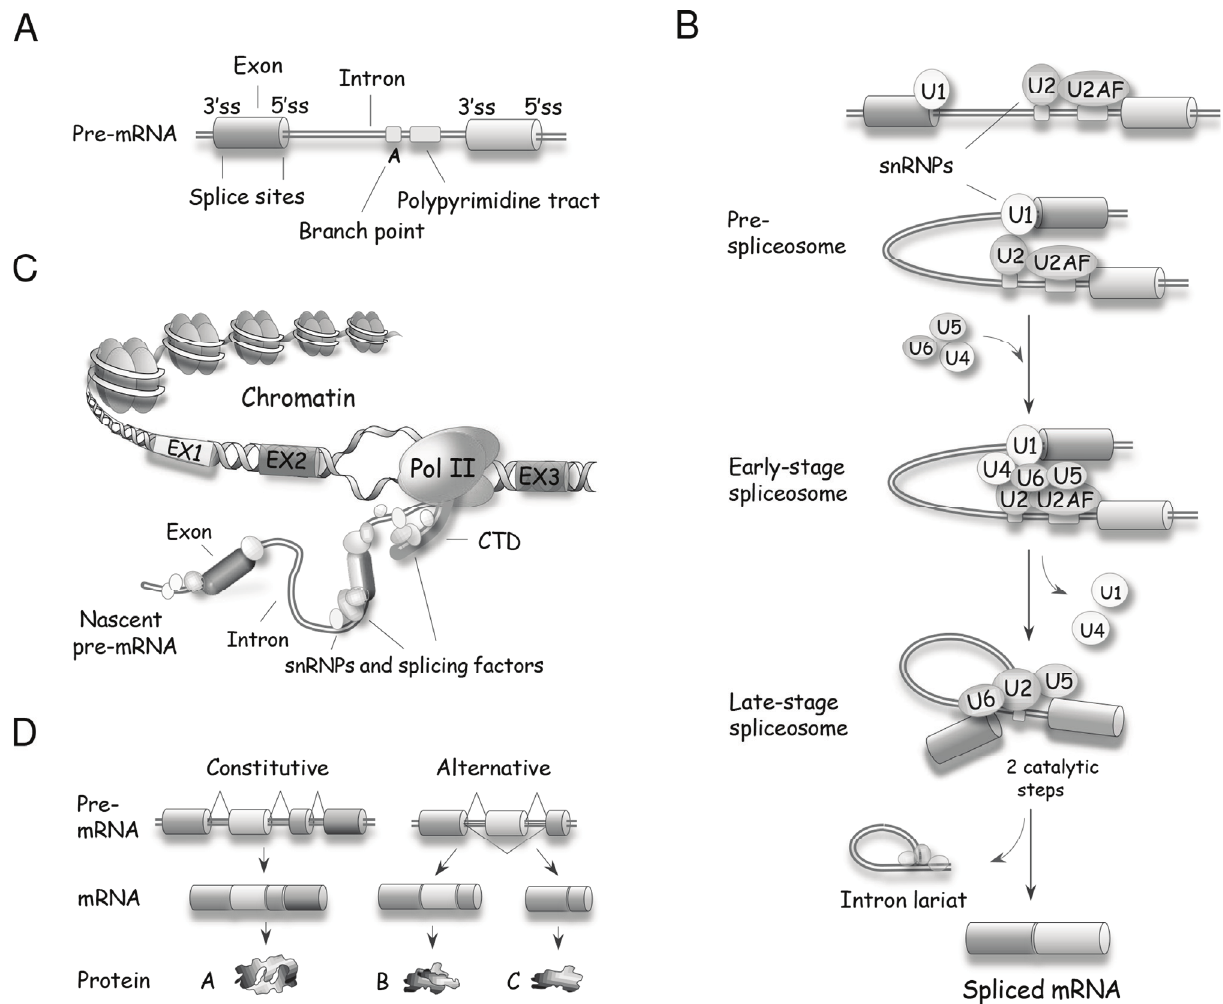
Figure 2. Basic principles of pre-mRNA splicing. ( A ) Schematic structure of a pre-mRNA with the position of core signal sequences that define exons and introns. ss: splice site; ( B ) A snRNP-biased view of spliceosome assembly leading to two catalytic steps that produce the mRNA and the excised intron. U2AF is a heterodimer made of the U2AF2 (U2AF65) and U2AF1 (U2AF35) proteins that respectively recognize the polypyrimidine tract and the AG dinucleotide at the 3' splice site [15]; ( C ) Spliceosome assembly is often coupled with transcription, with the carboxyl-terminal domain (CTD) of RNA polymerase II recruiting splicing components that are deposited on the nascent pre-mRNA; ( D ) In contrast to constitutive splicing, alternative splicing produces different mRNAs from a single kind of